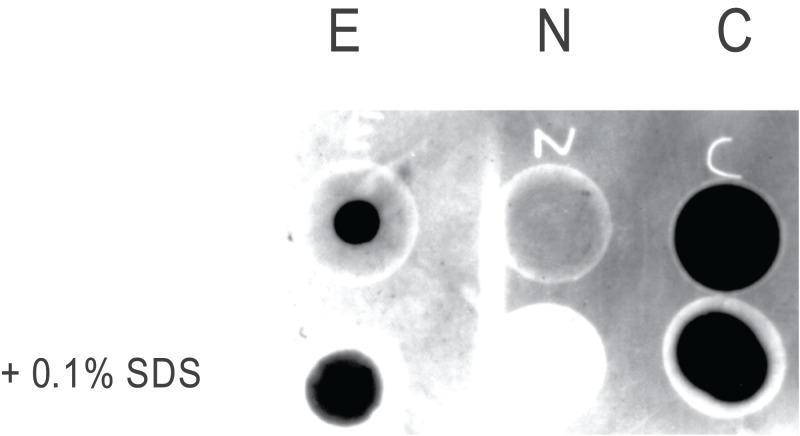
Dot blot epitope mapping of the goat anti-EPL001 antibody.The antibody was subjected to protein G purification. E = EPL001. N = N-terminus of EPL001 (i.e. MKPLTG). C = C-terminus of EPL001 (i.e. KVKEFNNI). Lower dots were +0.1% SDS.